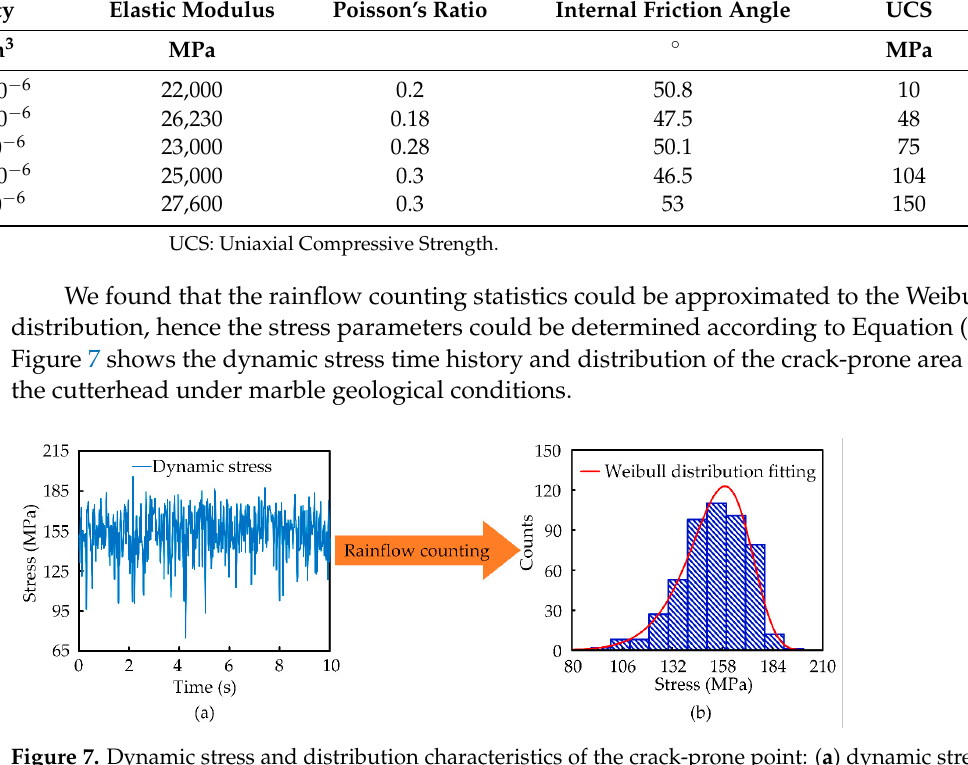
Figure 7. Dynamic stress and distribution characteristics of the crack-prone point: ( a ) dynamic stress and ( b ) the distribution.